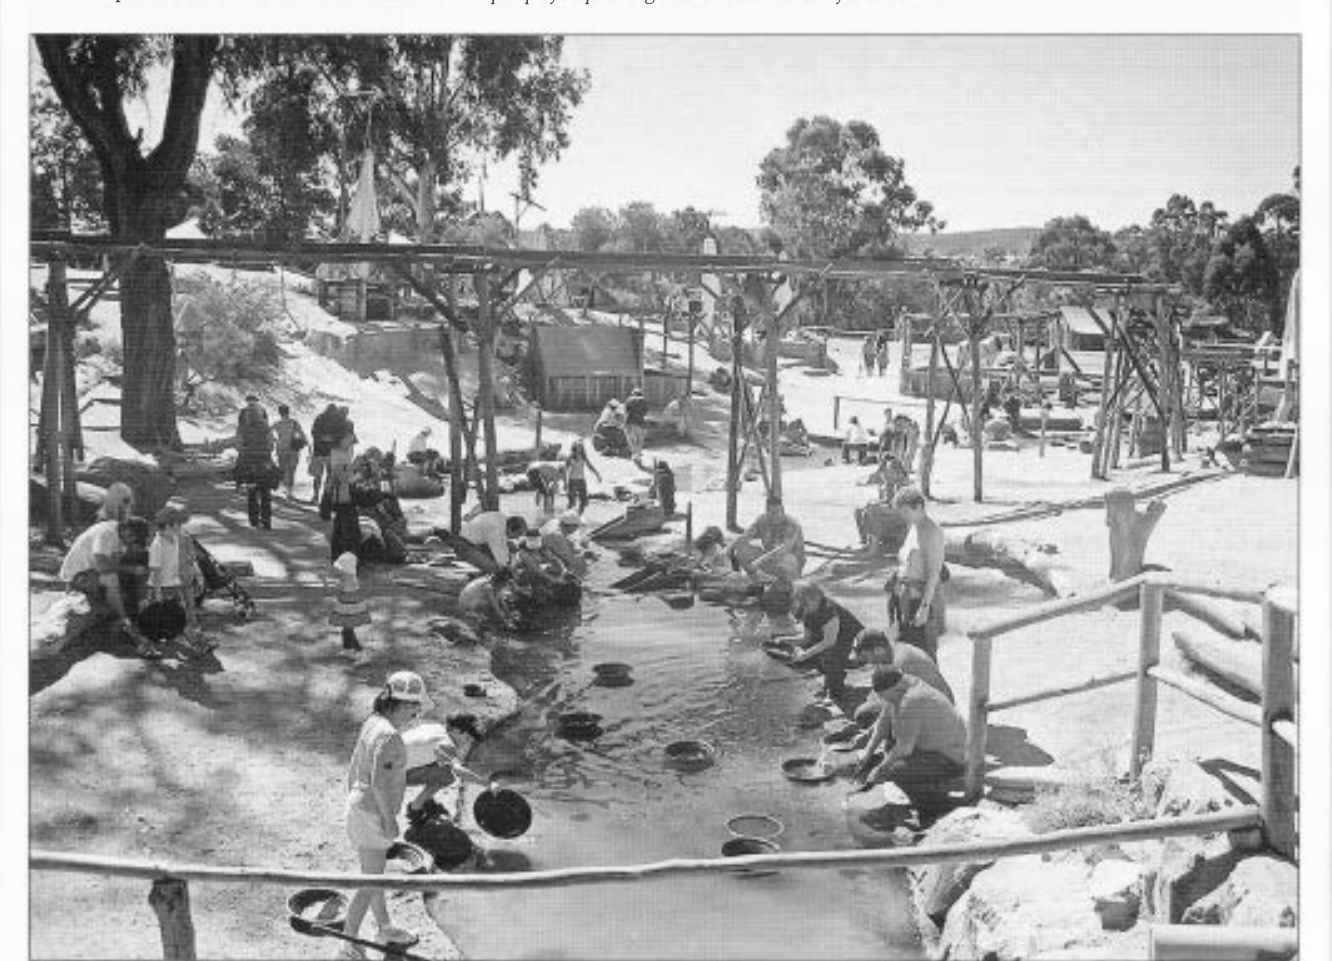
Figure 3 Panning for gold in Sovereign Hill Open Air Museum, Ballarat, Australia. The stream is replenished with gold flakes fort­ nightly for the amusement of visitors. Other attractions include fake snowfalls four times a day in